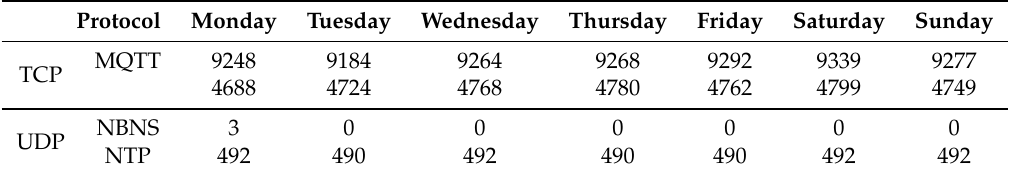
Table 6. Protocol composition.